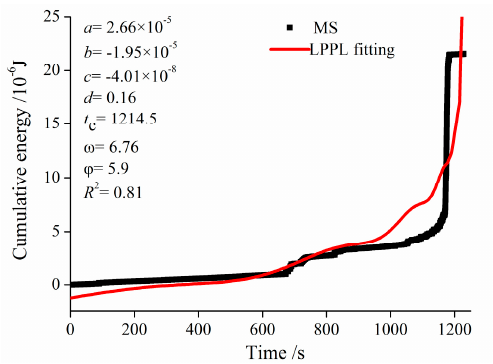
Figure 28. Log Periodic Power Law (LPPL) fitting of MS accumulative energy.